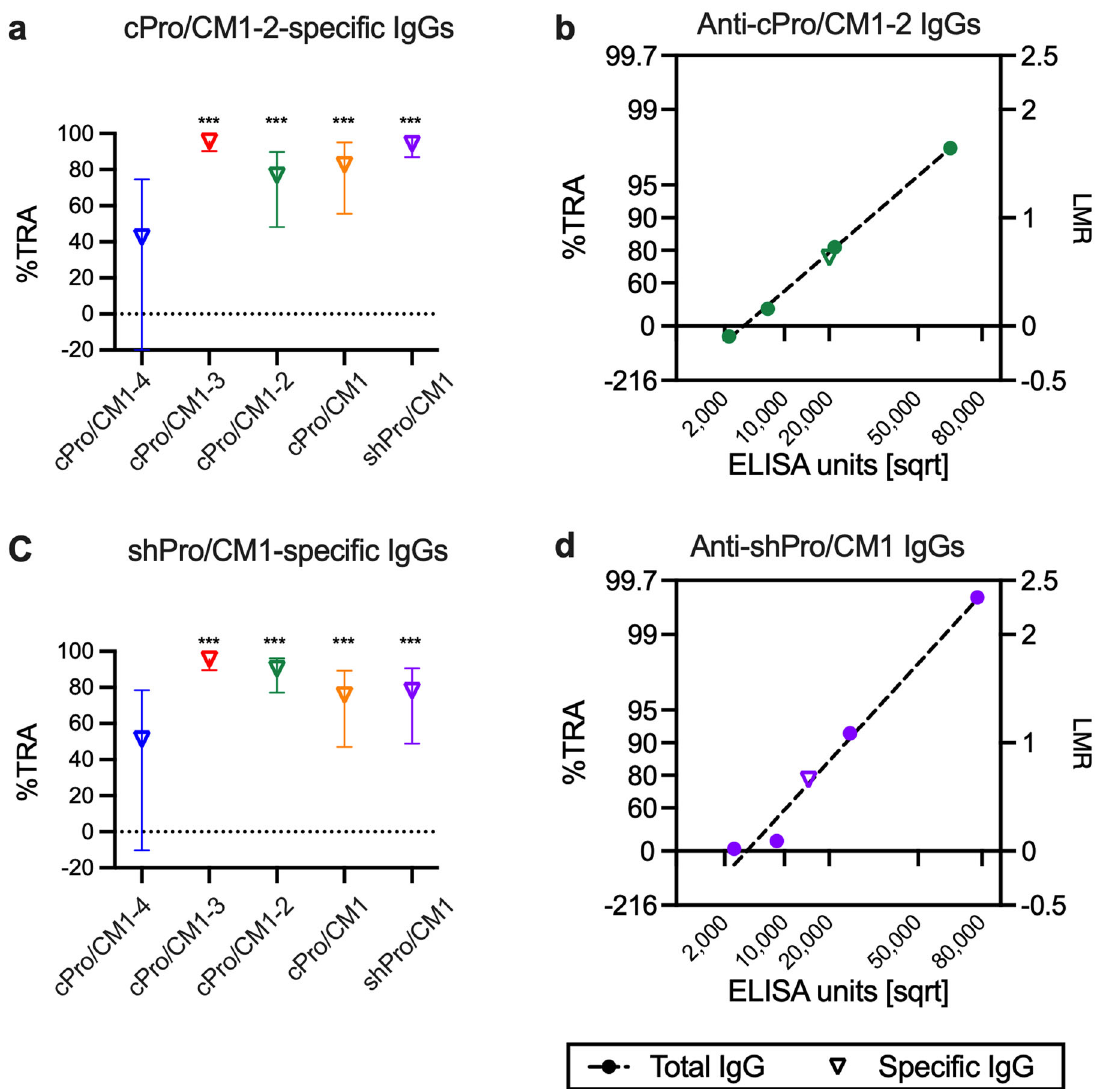
Fig. 3 cPro/CM1-2-speci fi c and shPro/CM1-speci fi c antibodies are functional. a cPro/CM1-2-speci fi c IgGs from the fi ve total IgGs were tested at 20,000 EU in a single assay, and the %TRA and the 95%CI are shown. *** p < 0.001. b SMFA results of anti-cPro/CM1-2 total IgG (at four different concentrations) and cPro/CM1-2-speci fi c IgG from the same total IgG (at 20,000 EU) are presented. Anti-cPro/CM1-2 ELISA units in a feeder (on a square root scale, sqrt) is shown on the x -axis, and the ratio of mean oocyst (mean oocyst density in control divided by mean in test) is plotted on a log scale (log of mean oocyst ratio, LMR, right side of y -axis). The associated %TRA value is shown on the left side of the y - axis. The dotted line represents the best estimate of the linear regression of the total IgG data (not including data point of the cPro/CM12- speci fi c IgG). c shPro/CM1-speci fi c IgG were tested at 15,000 EU in a single assay. *** p < 0.001. d SMFA results of anti-shPro/CM1 total IgG and the shPro/CM1-speci fi c IgG are presented in the same fashion as b shown in Fig. 3b, the af fi nity-puri fi ed shPro/CM1-speci fi c IgG from CM1-2 total IgG. Except for the speci fi c IgG from the anti-cPro/ the anti-shPro/CM1 total IgG showed an expected level of %TRA at CM1-4 total IgG (43%TRA, p = 0.158), the region-speci fi c IgGs from 15,000 ELISA units (Fig. 3d). These results indicate that the af fi nity the four other groups showed 77 – 96%TRA ( p < 0.002). The original puri fi cation procedure did not alter the quality of antibodies anti-cPro/CM1-2 total IgG and the region-speci fi c IgG from the (while there was a process loss in quantity of antibodies). same total IgG showed similar %TRA at the same ELISA units (Fig. When the af fi nity-puri fi ed cPro-speci fi c IgGs from total IgGs 3b). In the next set of experiments, af fi nity-puri fi ed shPro/CM1- from the fi ve groups were tested at the highest concentration, speci fi c IgGs were also tested at IC 80 concentration (i.e., 15,000 speci fi c IgGs from all fi ve groups showed >98%TRA ( p < 0.001; ELISA units) which was estimated from the original anti-shPro/ Feed 1 in Table S7). Therefore, the region-speci fi c IgGs were tested CM1 total IgG (Fig. 3c, Table S6). Similar to the cPro/CM1-2-speci fi c in two more independent assays at lower concentrations, and IC 80 IgGs, the shPro/CM1-speci fi c IgG from the anti-cPro/CM1-4 total IgG did not demonstrate signi fi cant activity (51%TRA, p = 0.096), values for each region-speci fi c IgG in µg/mL were calculated. The while the other four region-speci fi c IgGs did (76 – 96%TRA, p < IC 80 values were estimated from 38 – 88 µg/mL (Fig. 4a). Next 0.001). When the shPro/CM1-speci fi c IgG from the anti-cPro/CM1- shPro-speci fi c IgGs which were obtained by af fi nity puri fi cations 4 total IgG was tested at 22,158 ELISA units (the highest from the fi ve total IgGs were tested at the highest concentration, concentration), it showed 78%TRA ( p = 0.002). Similar to the data and four of region-speci fi c IgGs showed >99%TRA ( p < 0.001; Feed